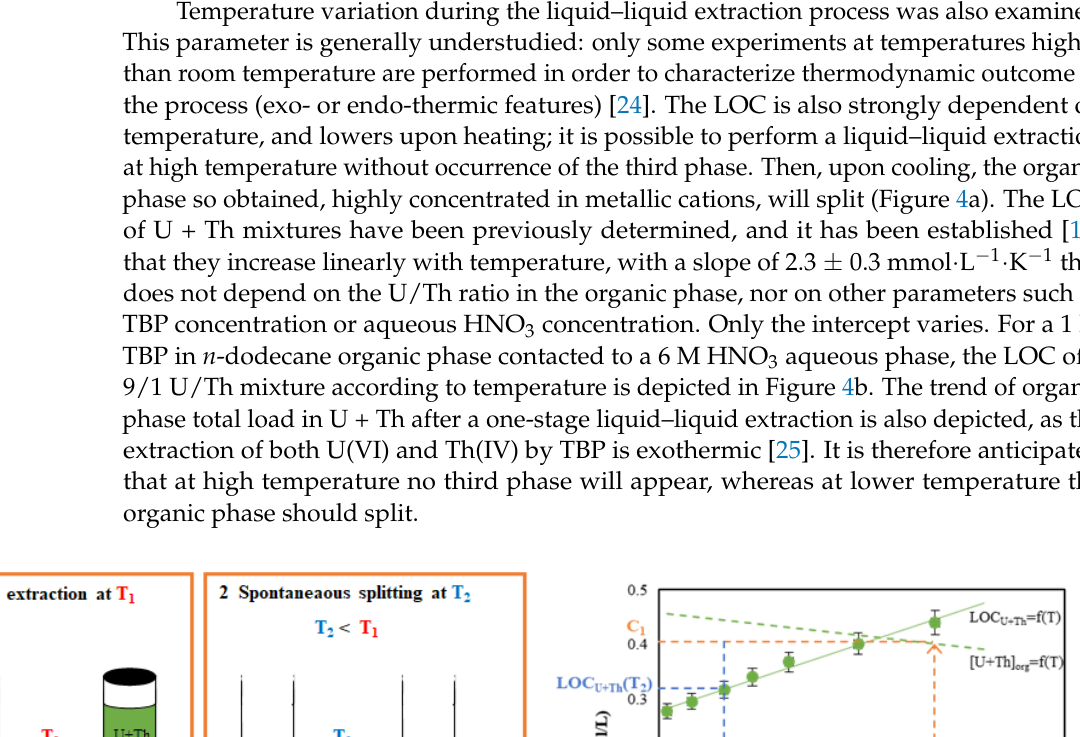
Table 3. Outcome of organic phase splitting upon cooling to a give temperature of an organic phase